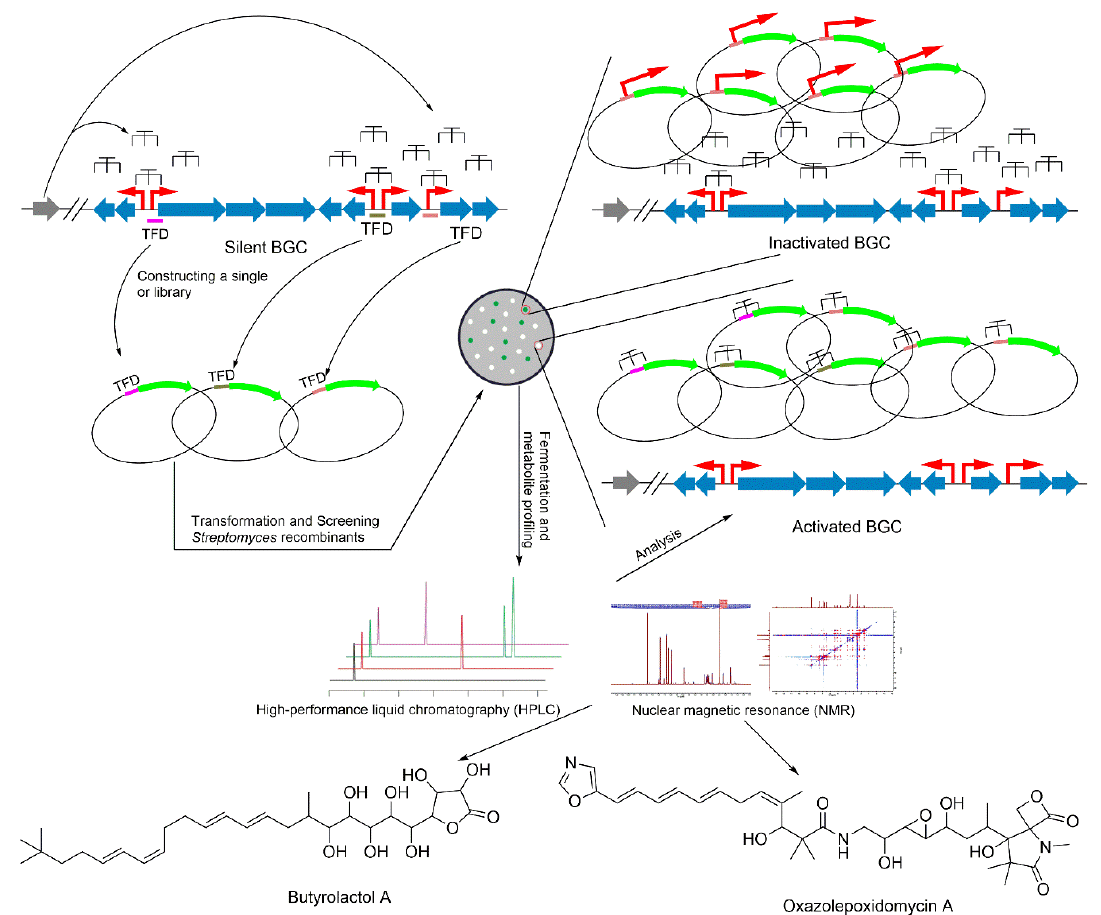
Figure 2. Overview of transcription factor decoy (TFD) strategy. The red arrows represent the promoter. The green arrows represent the reporter gene.